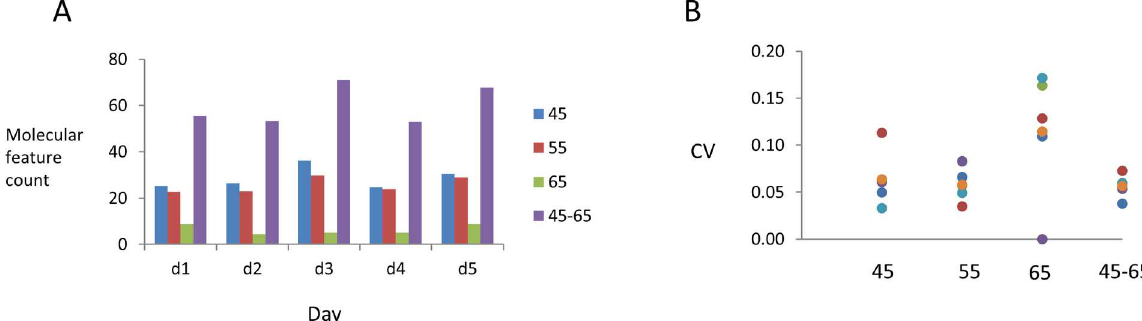
Fig 2. Intra-individual variability of molecular features detected in breath analysis. Molecular features (MF) were defined based on identified peaks with an intensity greater than a threshold of 0.5 pA. Twenty breath samples were collected using a standardized protocol from a single healthy volunteer over a five-day period. Chromatograms were extracted at a pre-defined compensation field at dispersion field (DF) settings of 45 V, 55 V or 65 V, and the number of MF present were quantitated. (A). The total number of MF identified at each DF setting, or with all three DF combined, on each of separate collection day. (B). The coefficient of variation (CV) of separate analyses at each DF setting alone or with all three DF combined is depicted. Colored dots indicate day of sample collection.